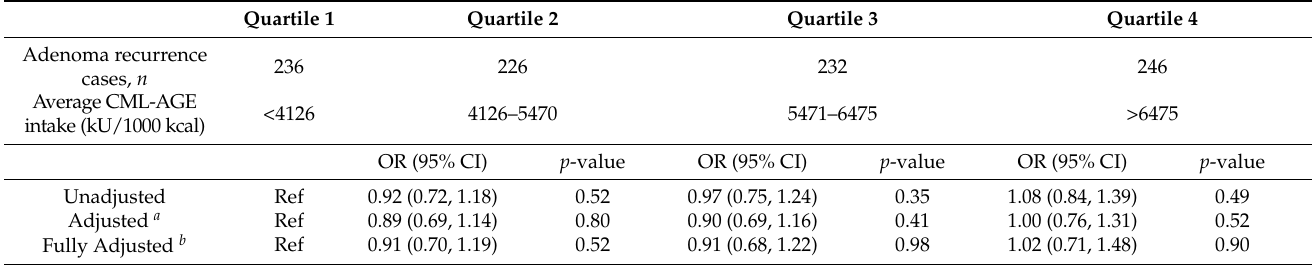
Table 2. Odds ratios (95% confidence intervals) for the association between CML-AGE intake and colorectal adenoma